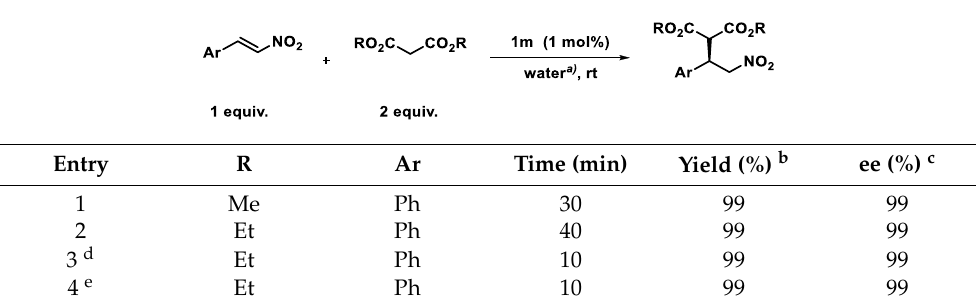
Table 1. Malonate scope of the Michael reaction using catalyst 1m.